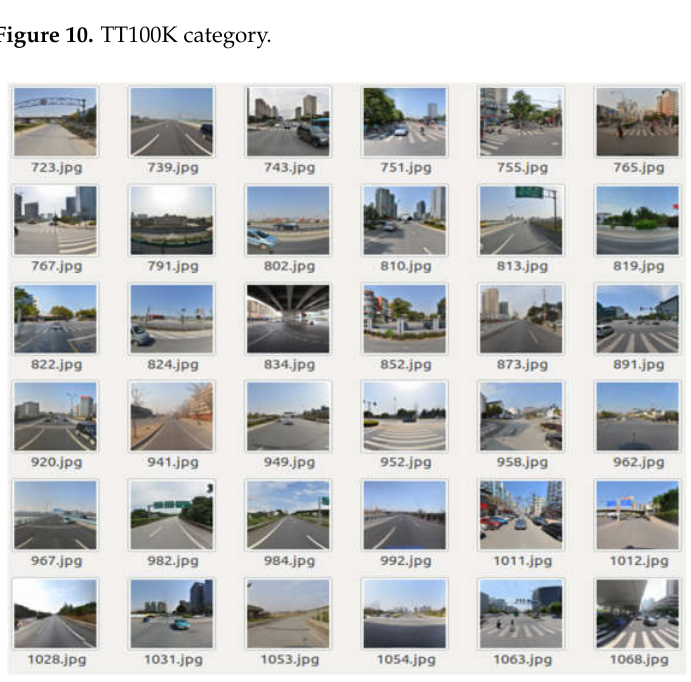
Figure 11. Sample dataset image.